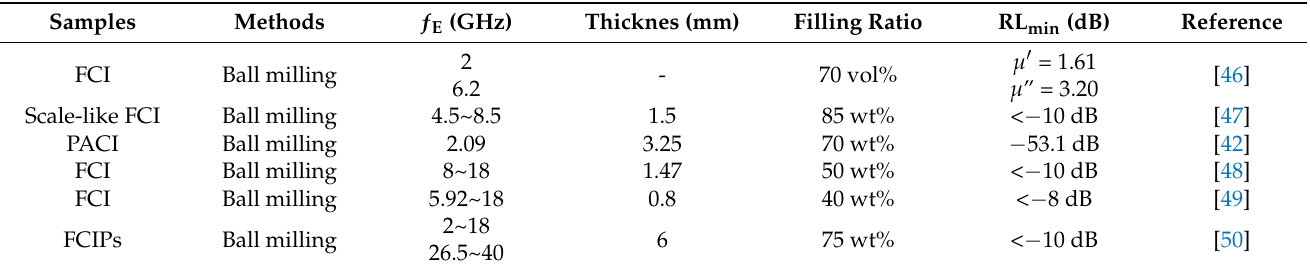
Table 2. The electromagnetic absorption performance of flaky-like